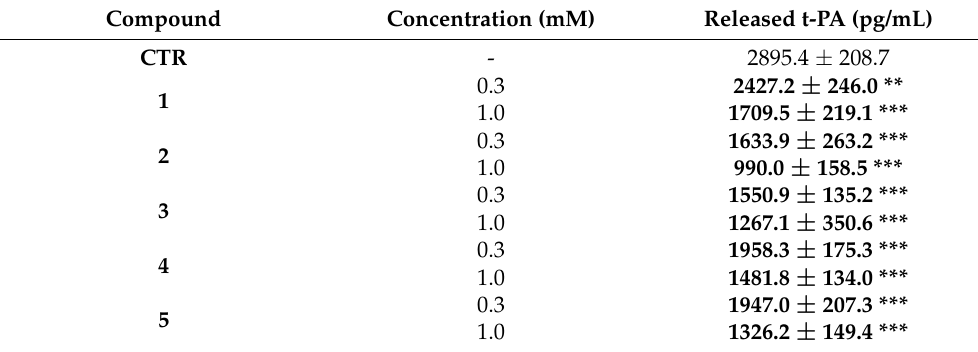
Table 2. Effects of sulfonamides 1 – 5 on the release of t-PA from HUVEC cells. The results (t- PA concentration in supernatants, pg/mL) are presented as mean ± SD ( n = 6). Values in bold are statistically significant in comparison with control samples. An asterisk denotes a significant difference between tested compounds and control samples (** p < 0.01; *** p < 0.001).